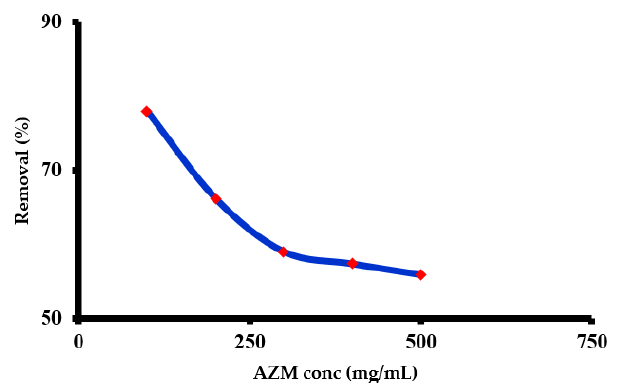
Figure 3. Removal performance of the AZM at different concentrations via ZnONPs.